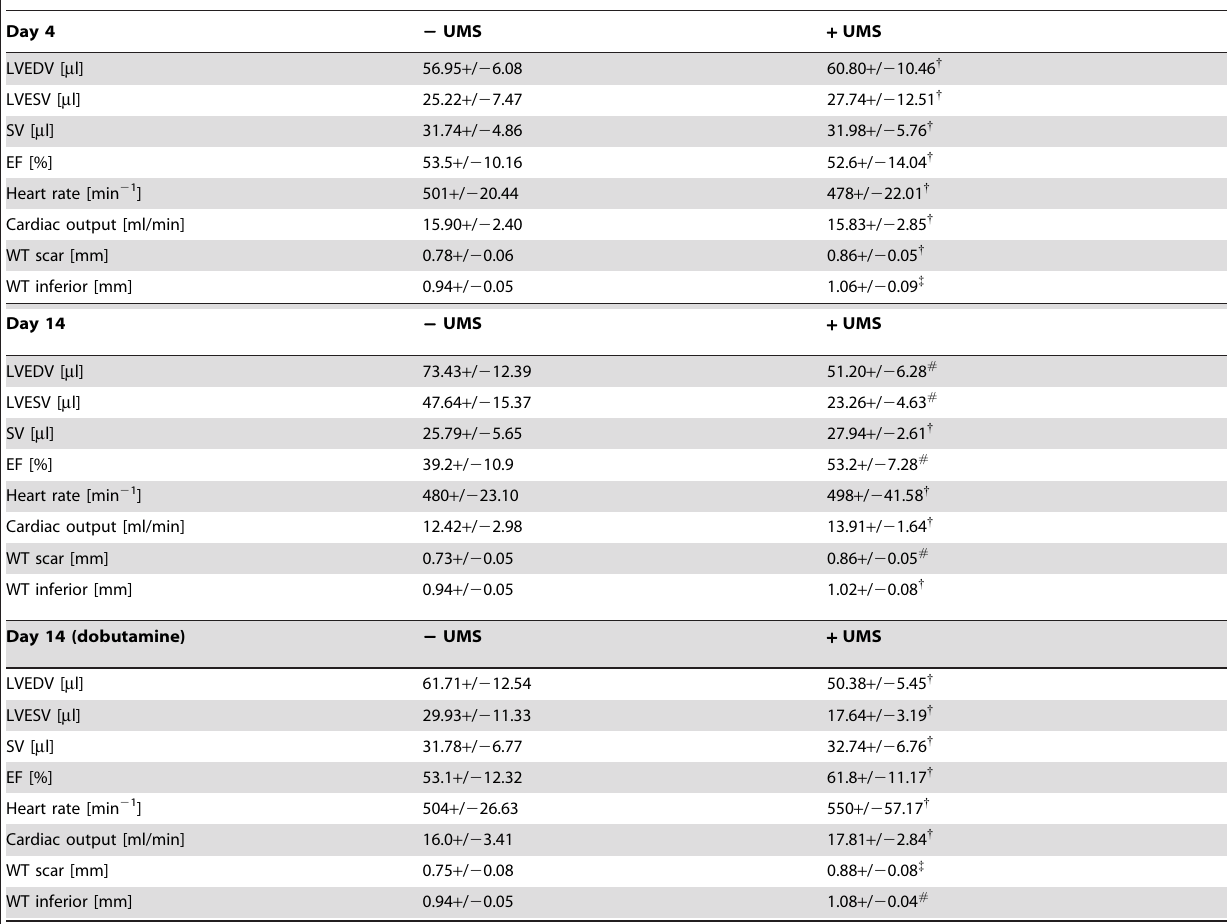
Table 1. Echocardiographic derived data